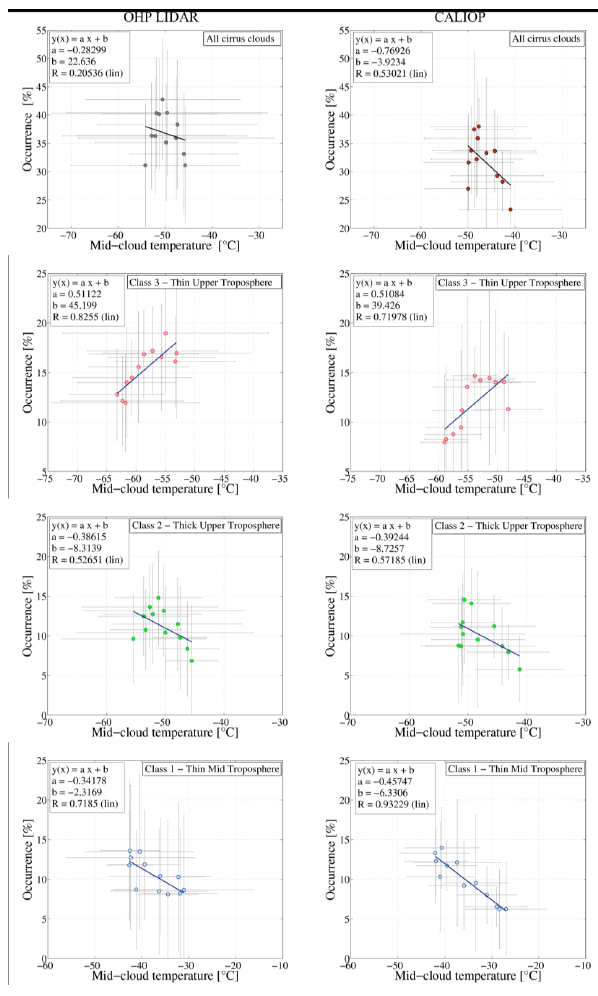
Figure 8. Monthly cirrus clouds occurrence as a monthly mid-cloud temperature function. The line represents the best linear fitting of the cirrus clouds occurrence as a temperature function for the different classes. Slope, intercept and correlation coefficient are presented on the left-upper corner of panels. Standard deviations are shown in gray. Class 1, 2 and 3 are presented C1, C1 and C3 labels on the right-upper corner of panels